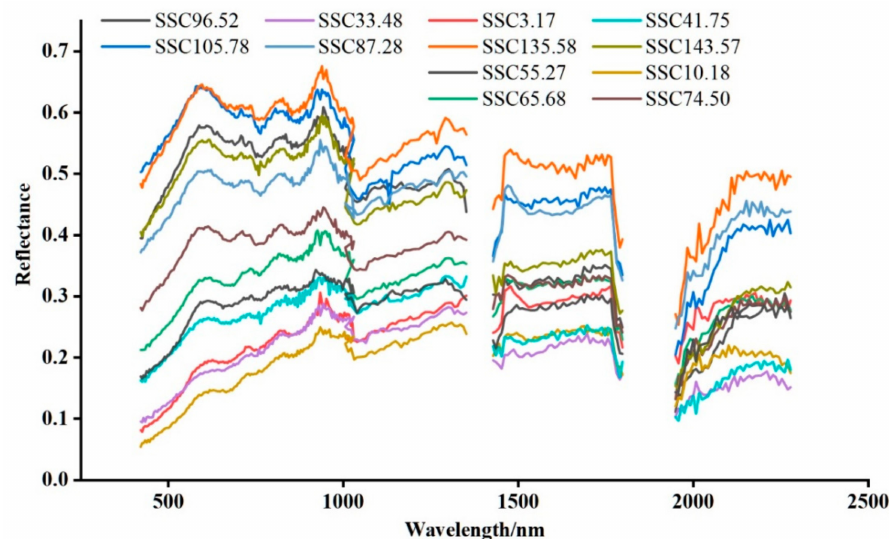
Figure 3. Spectral curves of soil samples on images obtained from the advanced hyperspectral imager (AHSI) sensor.